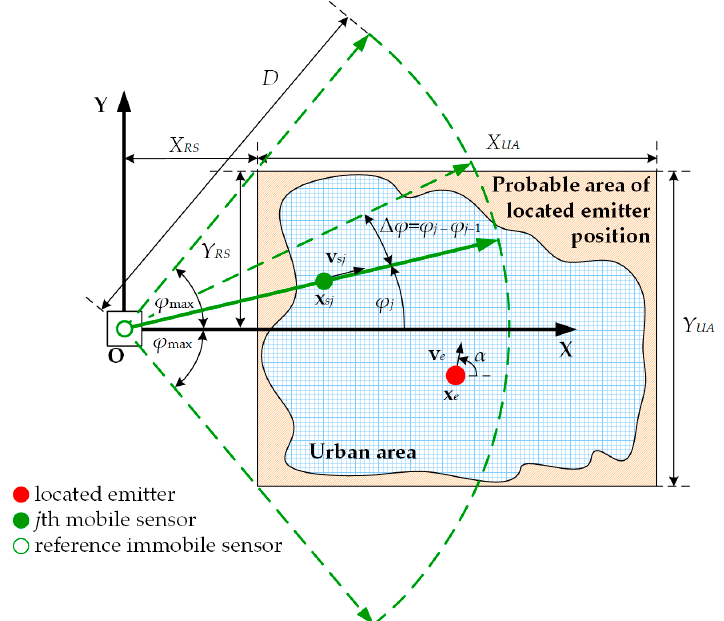
Figure 4. Spatial scenario of the simulation studies.